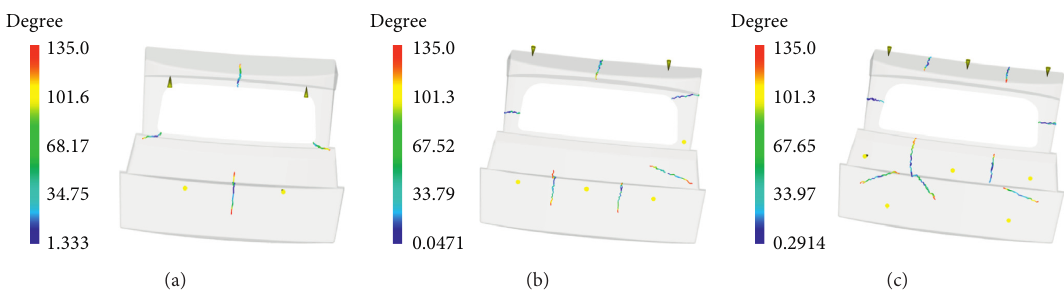
Figure 7: Welding line with (a) four gates, (b) six gates, and (c) eight gates. Table 4: Analysis results of three different gate schemes.